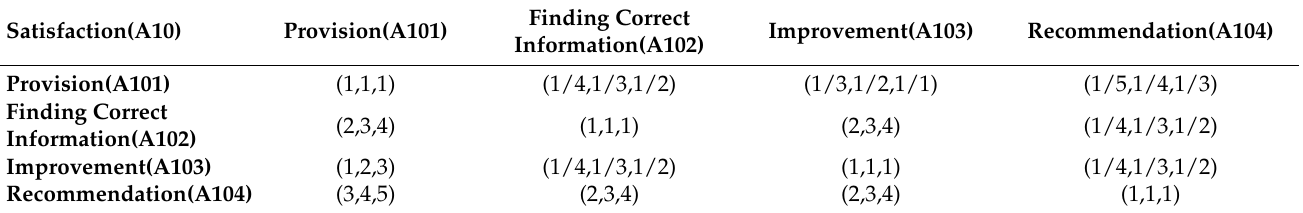
Table 14. Fuzzy-based comparison matrix associated with the sub-criteria in relation to the satisfaction (A10) criteria.